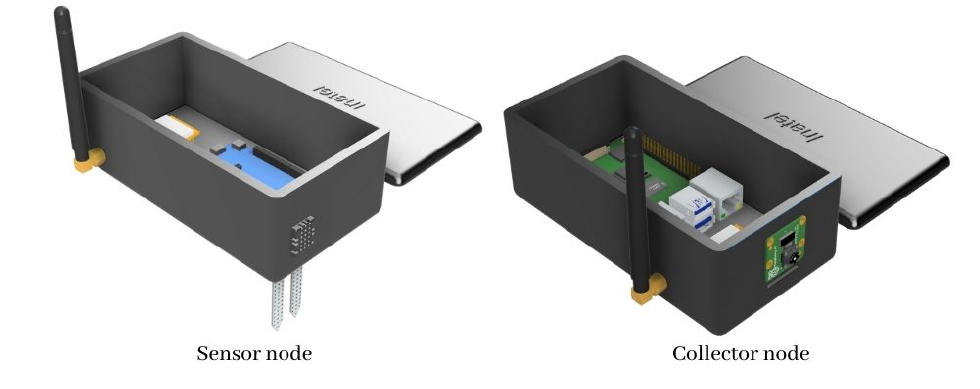
Figure 11. Sensor node and collector node digital design.